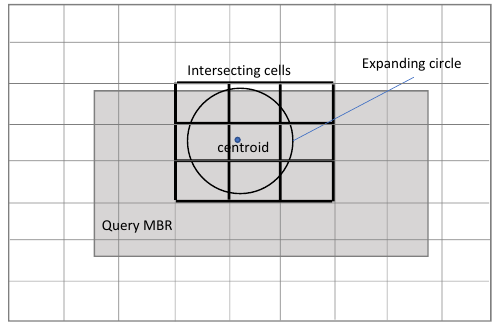
Figure 3. Cells overlapping with centroid’s